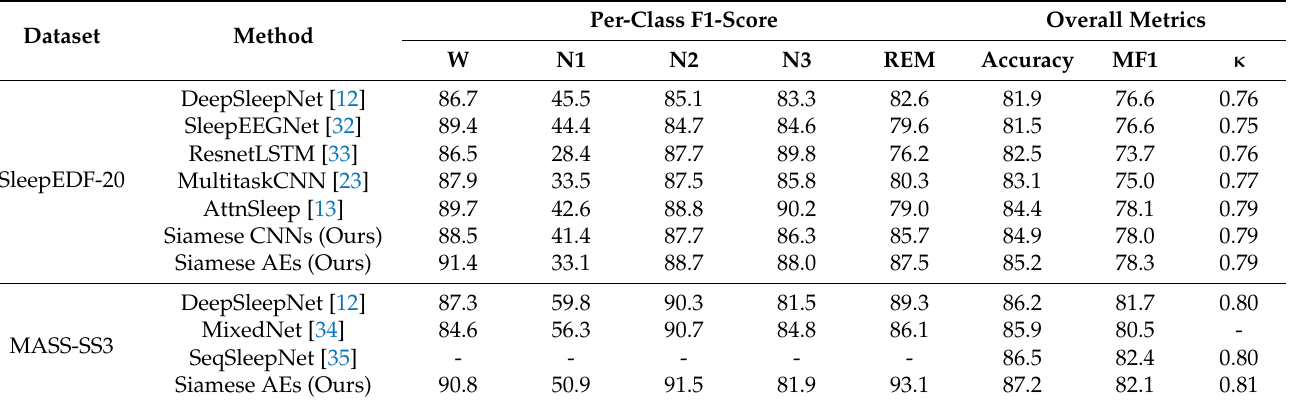
Table 5. Comparison of our method with other state-of-the-art (SOTA) sleep staging methods. The hyphen in the table represents that the value is